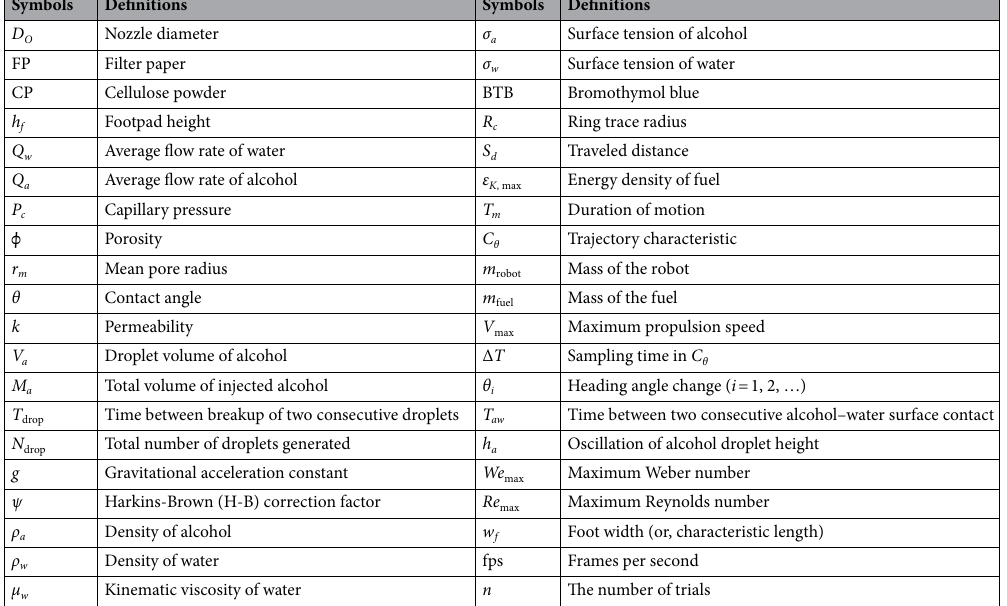
Table 2. The definitions of all the parameters and acronyms used on the main